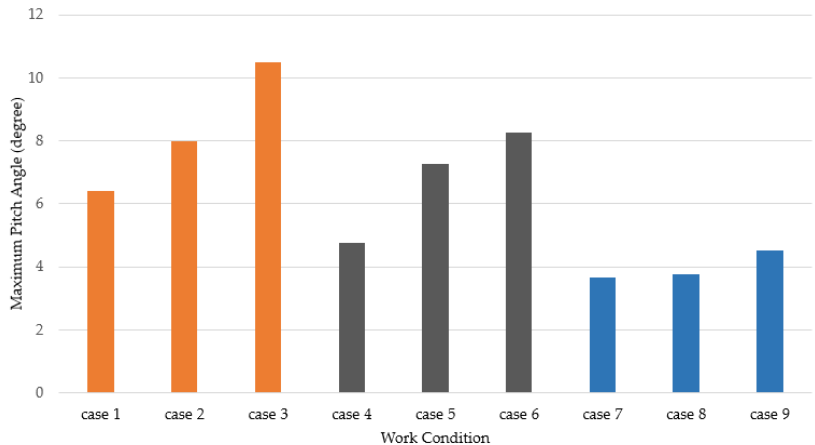
Figure 7. Analysis of heave of the USV.